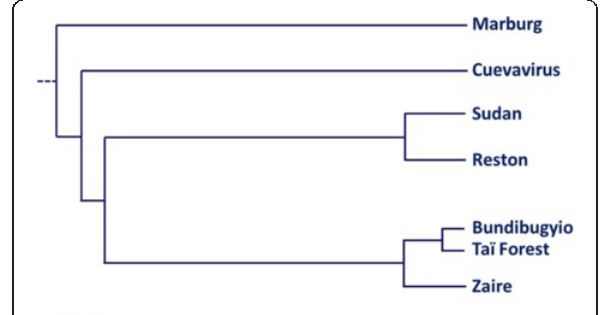
Figure 2 Tentative of Filoviridae phylogeny (scale on bottom left represents about 100 years)